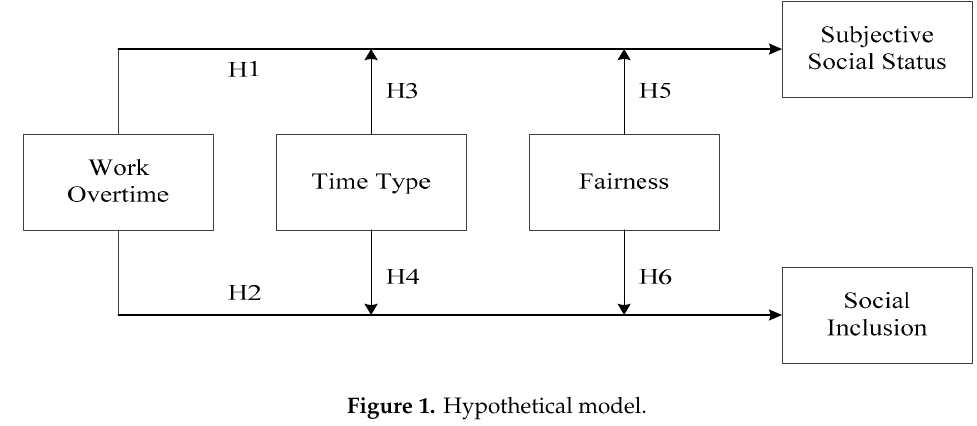
Figure 1. Hypothetical model.